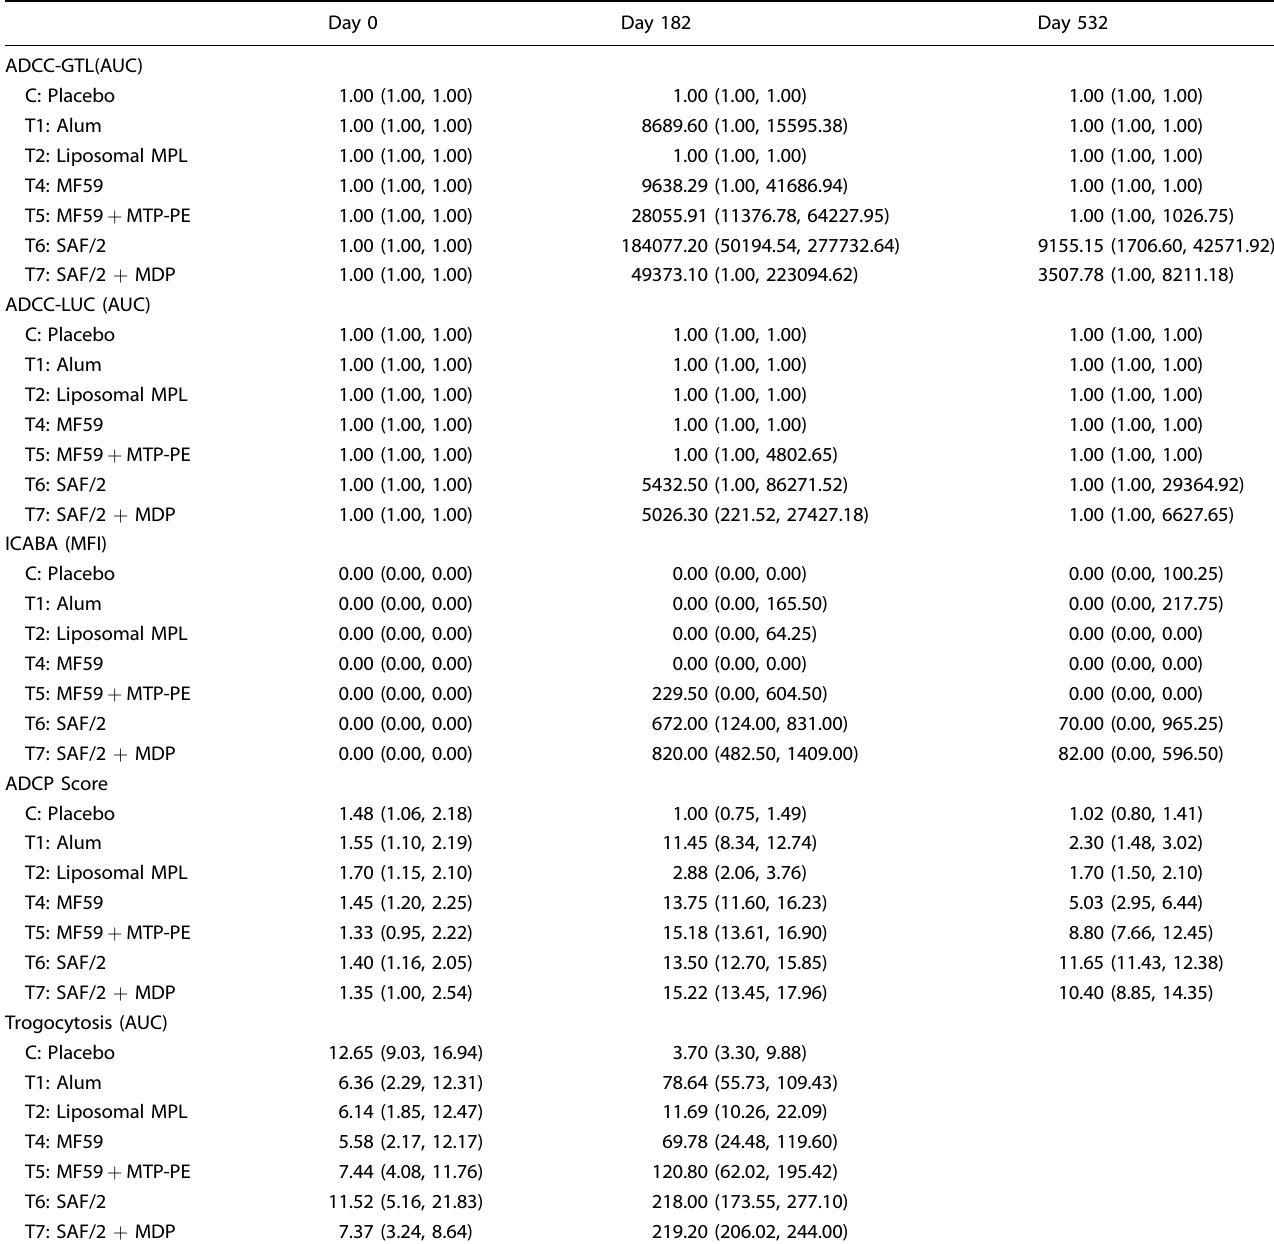
Table 1. Functional antibody response summary. Day 0 Day